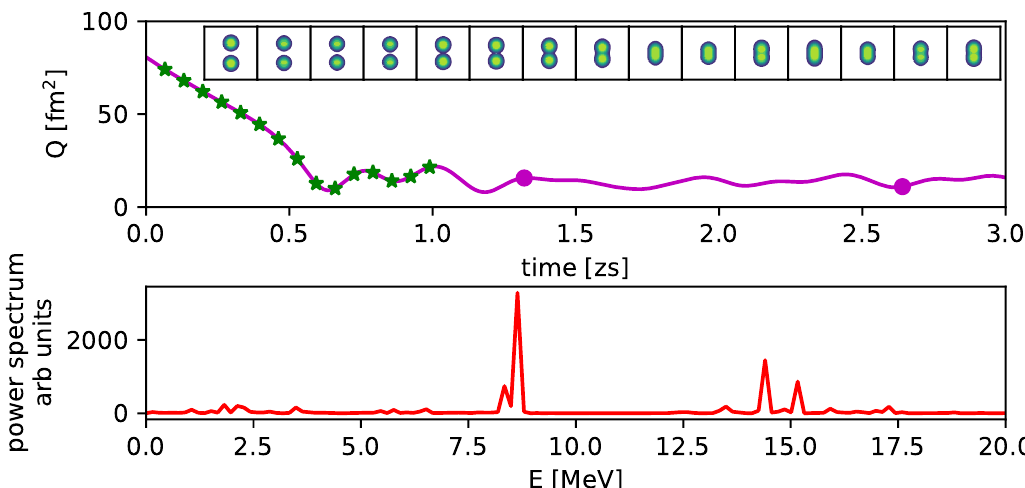
Figure 1: Upper panel shows the quadrupole moment of matter distribution of two colliding alpha particles. Two solid circles show the snapshots after 2000 and 4000 iterations when the wave functions of the 8 Be ∗ are taken to be used as starting points in the triple alpha calculations. Starred points correspond to the density snapshots in the inset frames. The lower panel shows the power spectrum of the oscillations of the compound 8 Be